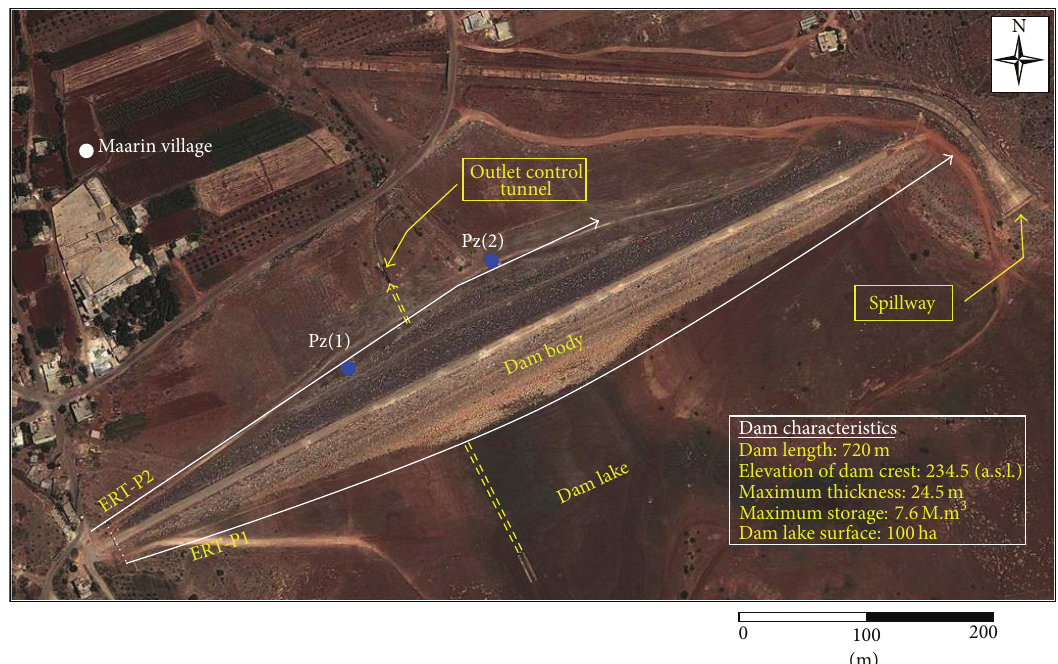
Figure 3: Locations of the ERT profiles realized at up- and downstream sides of Abu Baara dam; Pz(1) and Pz(2): piezometric boreholes located behind the dam